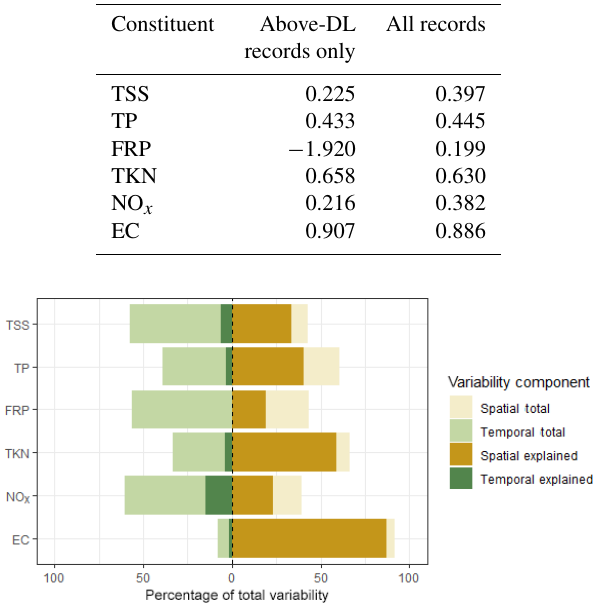
Table 3. Comparison of model performance for all records and the above-DL records only for each constituent.